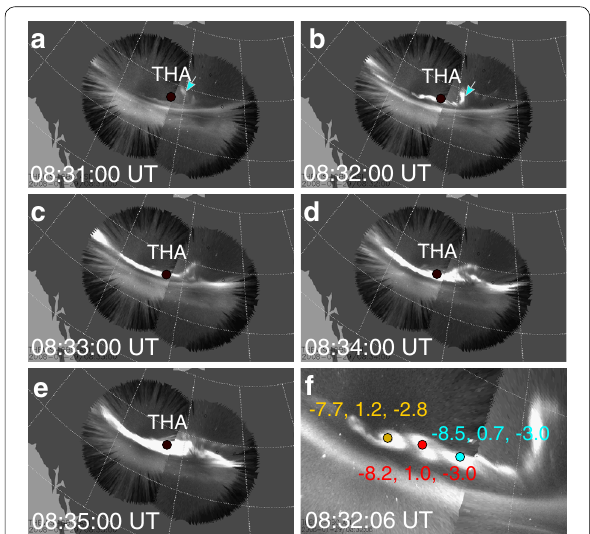
Fig. 1 Time sequences of auroral activities from ASIs [the left station is Fort Simpson (FSIM), and the right station is Fort Smith (FSMI)]. The black dot in a – e is the footpoint of THEMIS-A from AM03 model. f The zoom-in auroral snapshot at 08:32:06 UT; the yellow , red , and blue dots are identified by eye to represent the locations of three identical auroral